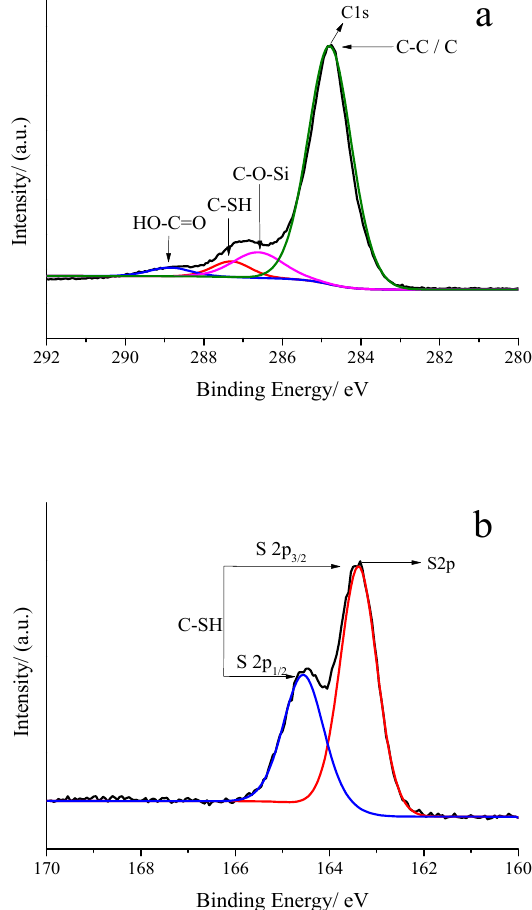
Figure 19. High resolution XPS spectra of GOs-SH of C1s ( a ) and S2p ( b ).